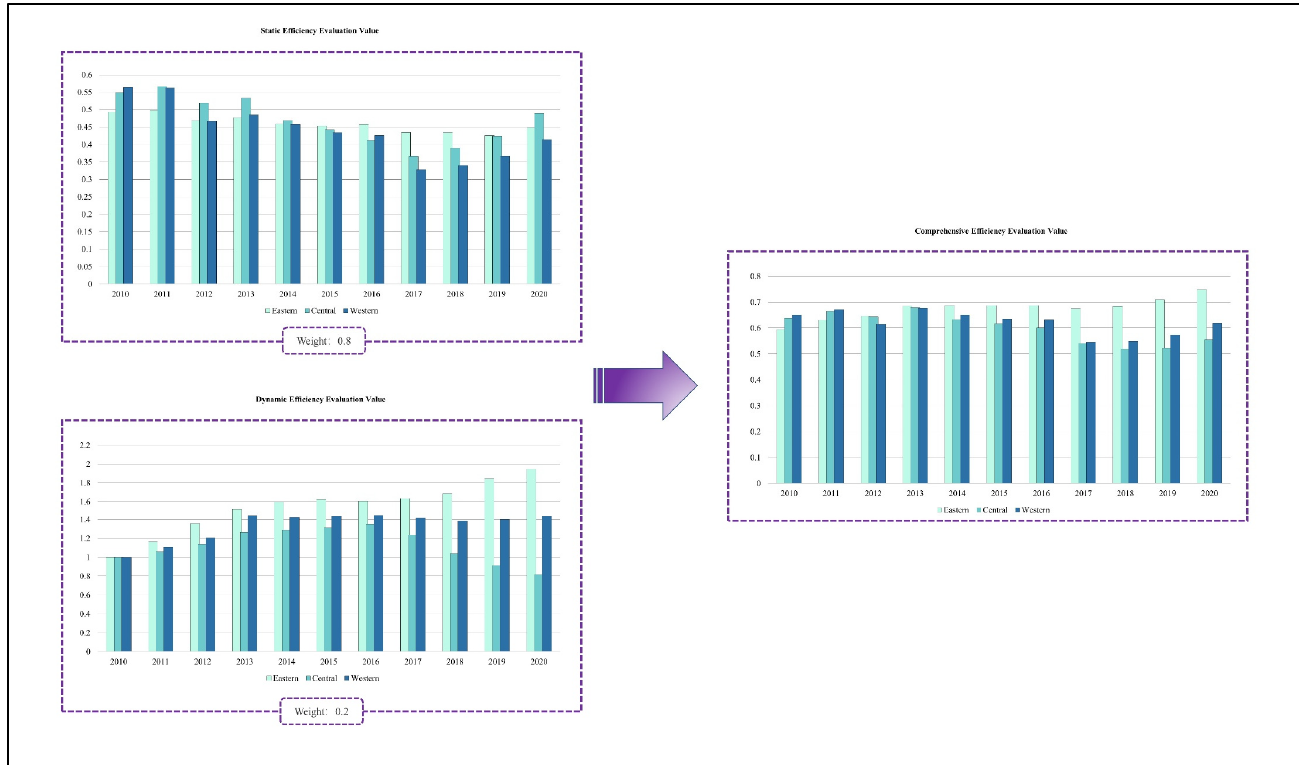
Figure 6. Histogram of construction productivity in the eastern, central, and western regions.